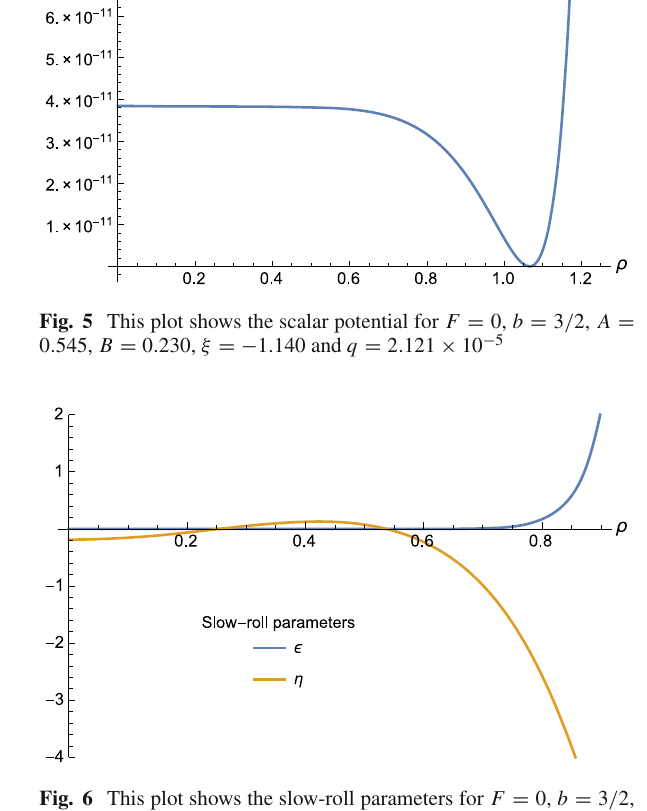
Table 1 The theoretical predictions for ρ ∗ = 0 . 055 and ρ end = 0 . 403 and the parameters given in Eq. (52)